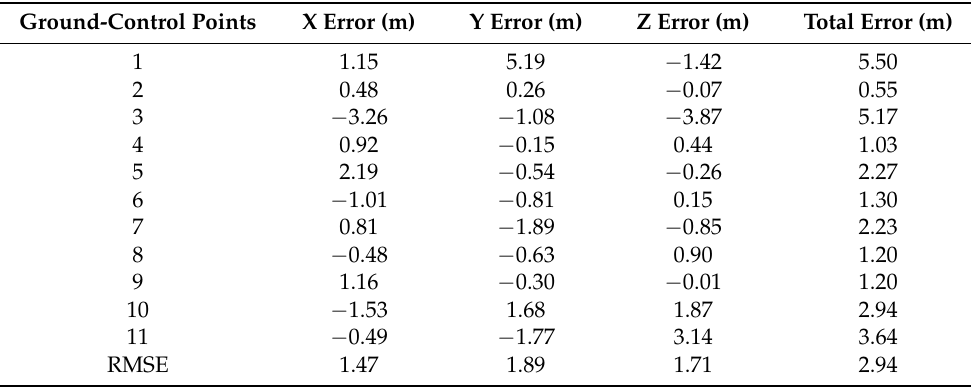
Table 2. The errors of ground-control